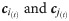
Three indices of children’s group behavior.Illustrated above are ci(t)andcj(t), a pair of children at the current time t of the video frame. The time interval is 0.05 s. The first index (A) is the distance |dj| (cm) between a pair of children. The second index (B) is θij (degree), which represents the angle between the velocity vector of a child and the vector composed of positions of a pair of children at the current time, t. The linear data ranges from 0 to 180 degrees. If θij is close to 0 degrees, it indicates that a child runs in the direction of another child. The third index (C) is mi, which represents the angular momentum of a child and measures the degree of rotation movement. The range is from 0 to 1. It is calculated by the cross product of the unit vectors composed of the static center of the group of children c¯group, and the velocity vector of a child.